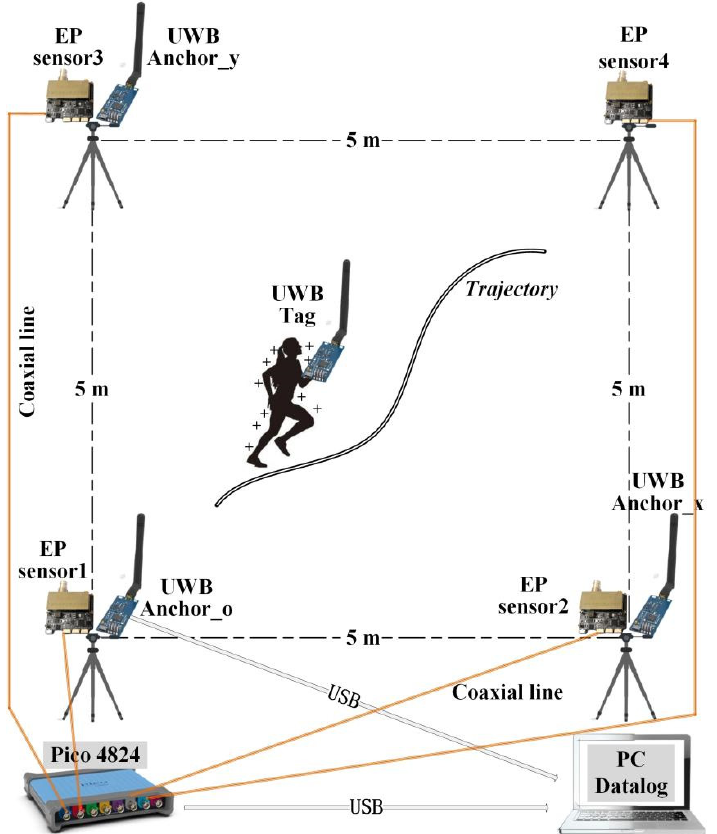
Figure 3. Experimental scene layout of the remote test of human electrostatic potential.